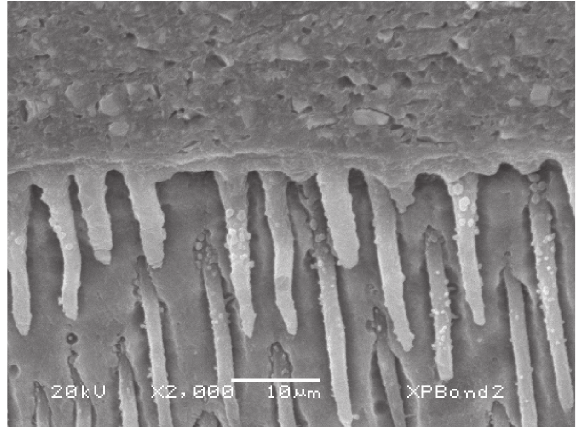
Figure 8- A thick layer of adhesive can be seen when XP Bond (T-Butanol solvent) was applied. It is also possible